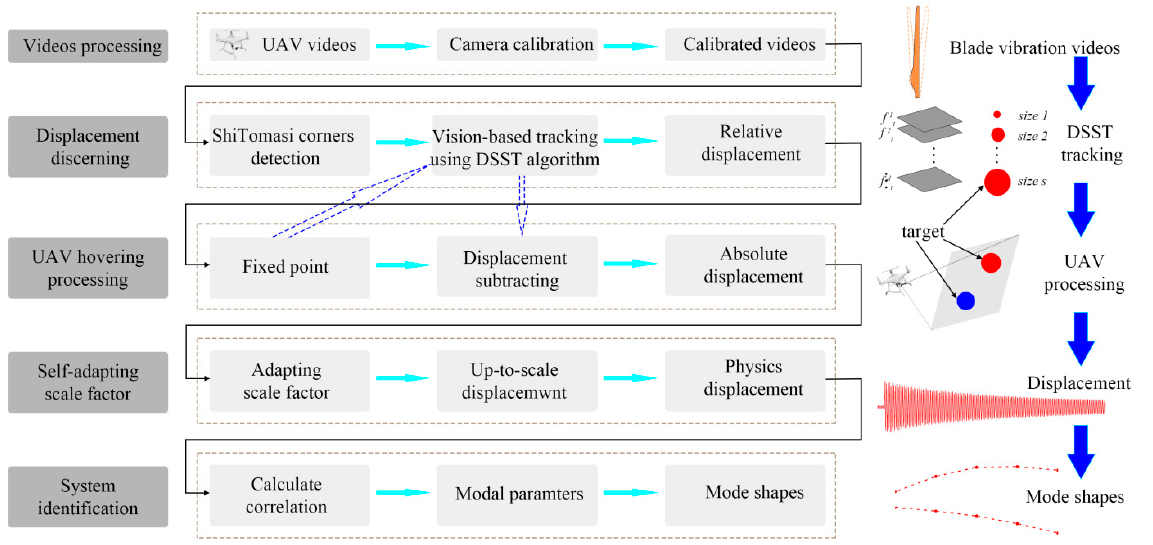
Figure 11. Target-free DSST vision algorithm and general steps for UAV monitoring of dynamic properties of structures.